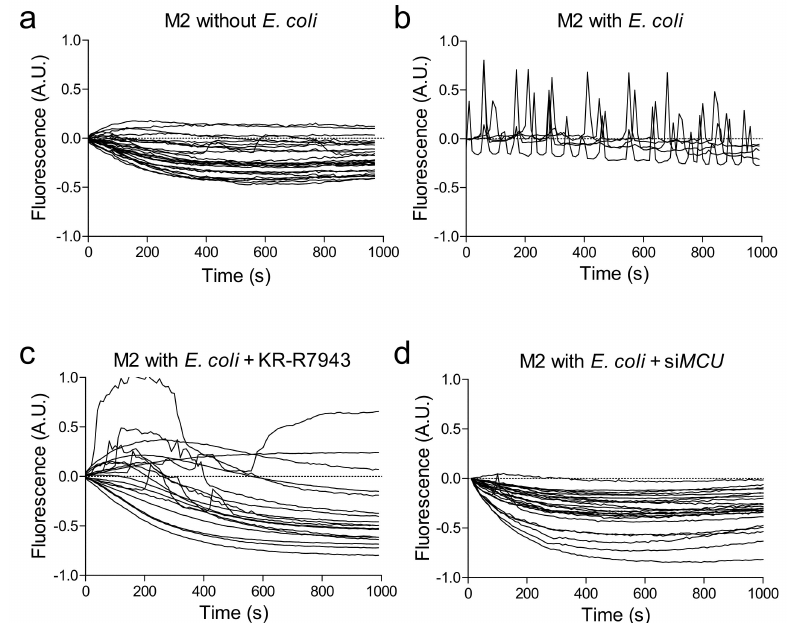
Figure 2. Mitochondrial calcium spikes during phagocytosis. Mitochondrial calcium concentrations, recorded as Rhod-2 fluorescence intensity, were imaged real-time in M2-polarized macrophages in the unstimulated condition ( a ) and after challenge with E. coli fragments without ( b ) or with ( c ) the MCU inhibitor KB-R7943 or transfection with siRNA against MCU ( d ). In each plot, individual lines represent the fluorescence intensity of regions of interest (ROI) drawn around each macrophage.